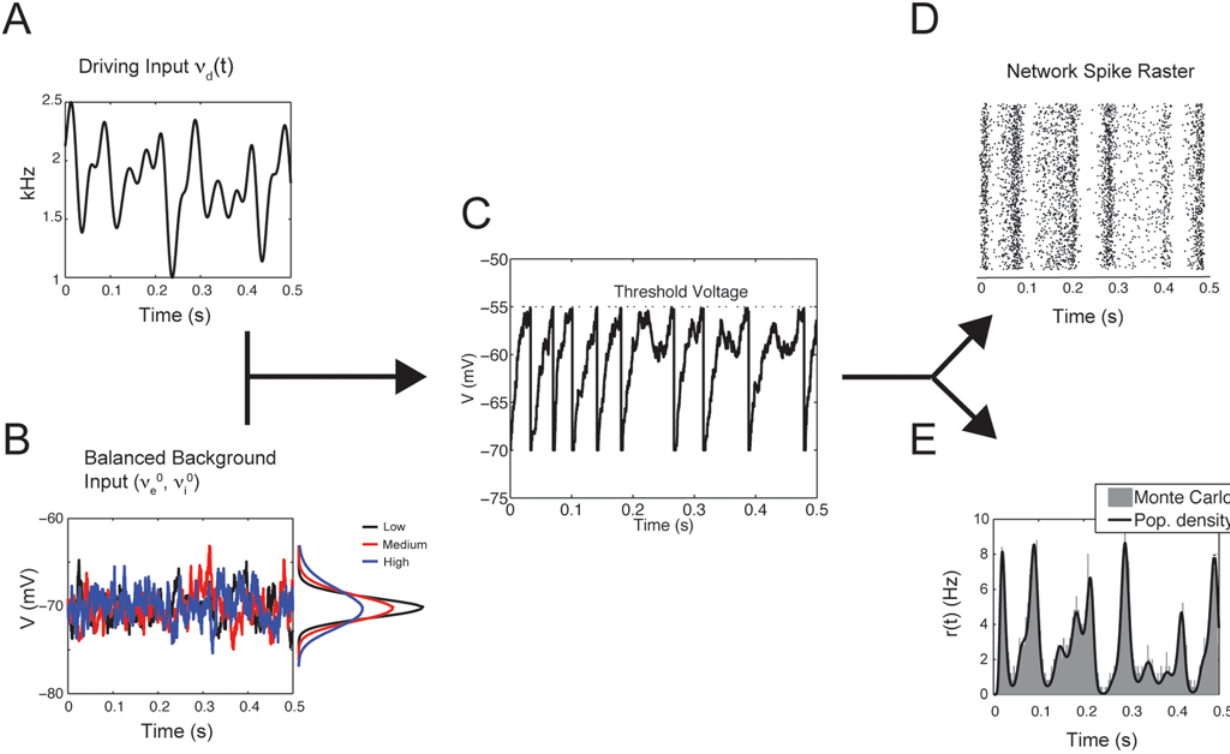
Figure 1. Input-output schematic for population of LIF neurons with a combination of driving input and balanced background fluctuations. (A) Excitatory driving input with rate n d t ð Þ . (B) Balanced fluctuating background inputs with rates n 0 the evolution of u is shown when n d t ð Þ ~ 0 ; three intensities of background input are shown. (C) Sample realization of the LIF dynamic. (D) Raster plots of the output spikes are shown (Monte Carlo). (E) The output firing rate r t ð Þ , computed by the population density method (see Equations (6)–(8)), is a fast and efficient method for capturing the output firing rate. It matches the average firing rate of 100,000 random LIF neurons computed by Monte Carlo simulation.